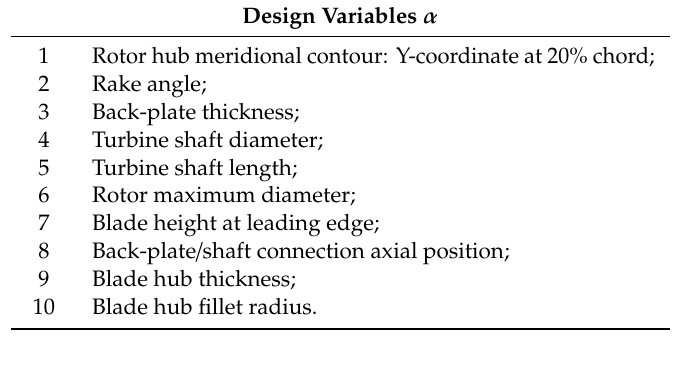
Table 6. Design variables adopted in the dJ / d α gradient validation.